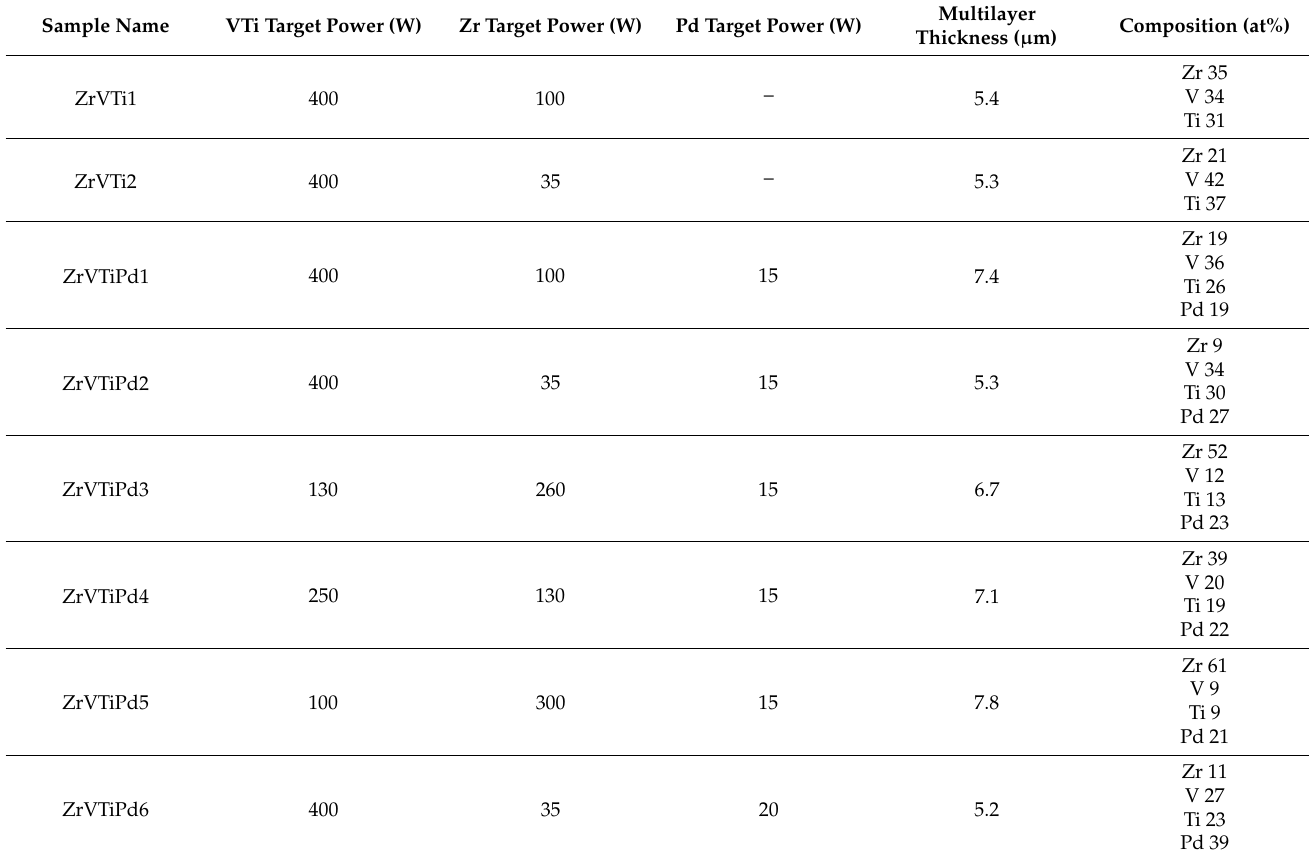
Table 1. Deposition conditions and the corresponding thickness and alloy composition measured via EDS on some representative